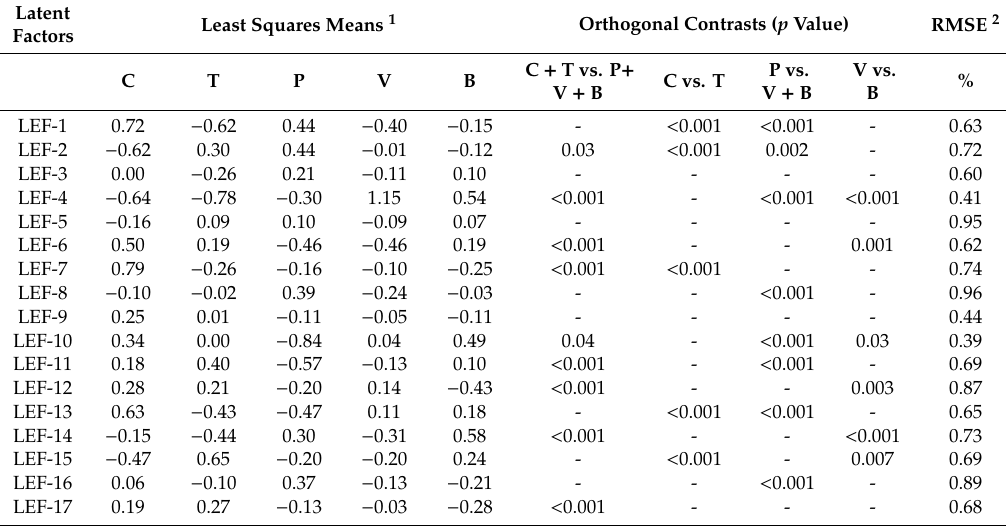
Figure 2. Number of volatile organic compounds (VOCs) with significant di ff erences in favor of the first vs. second term of the contrasts ( p < 0.05 1st), in favor of the second vs. first term of the contrasts ( p < 0.05 2nd) and with no significant di ff erences between the 2 terms of the contrasts (ns) for each of the four orthogonal contrasts tested (C = chicken; T = turkey; P = pork; V = veal; and B = beef meat). Table 3. Effects of meat species and category on the least square means and contrast significance of the scores of the latent explanatory factors (LEF) of volatile organic compounds’ proportions in cooked meat patties (in bold the correlation coefficient higher than 0.5 or lower than −0.5).